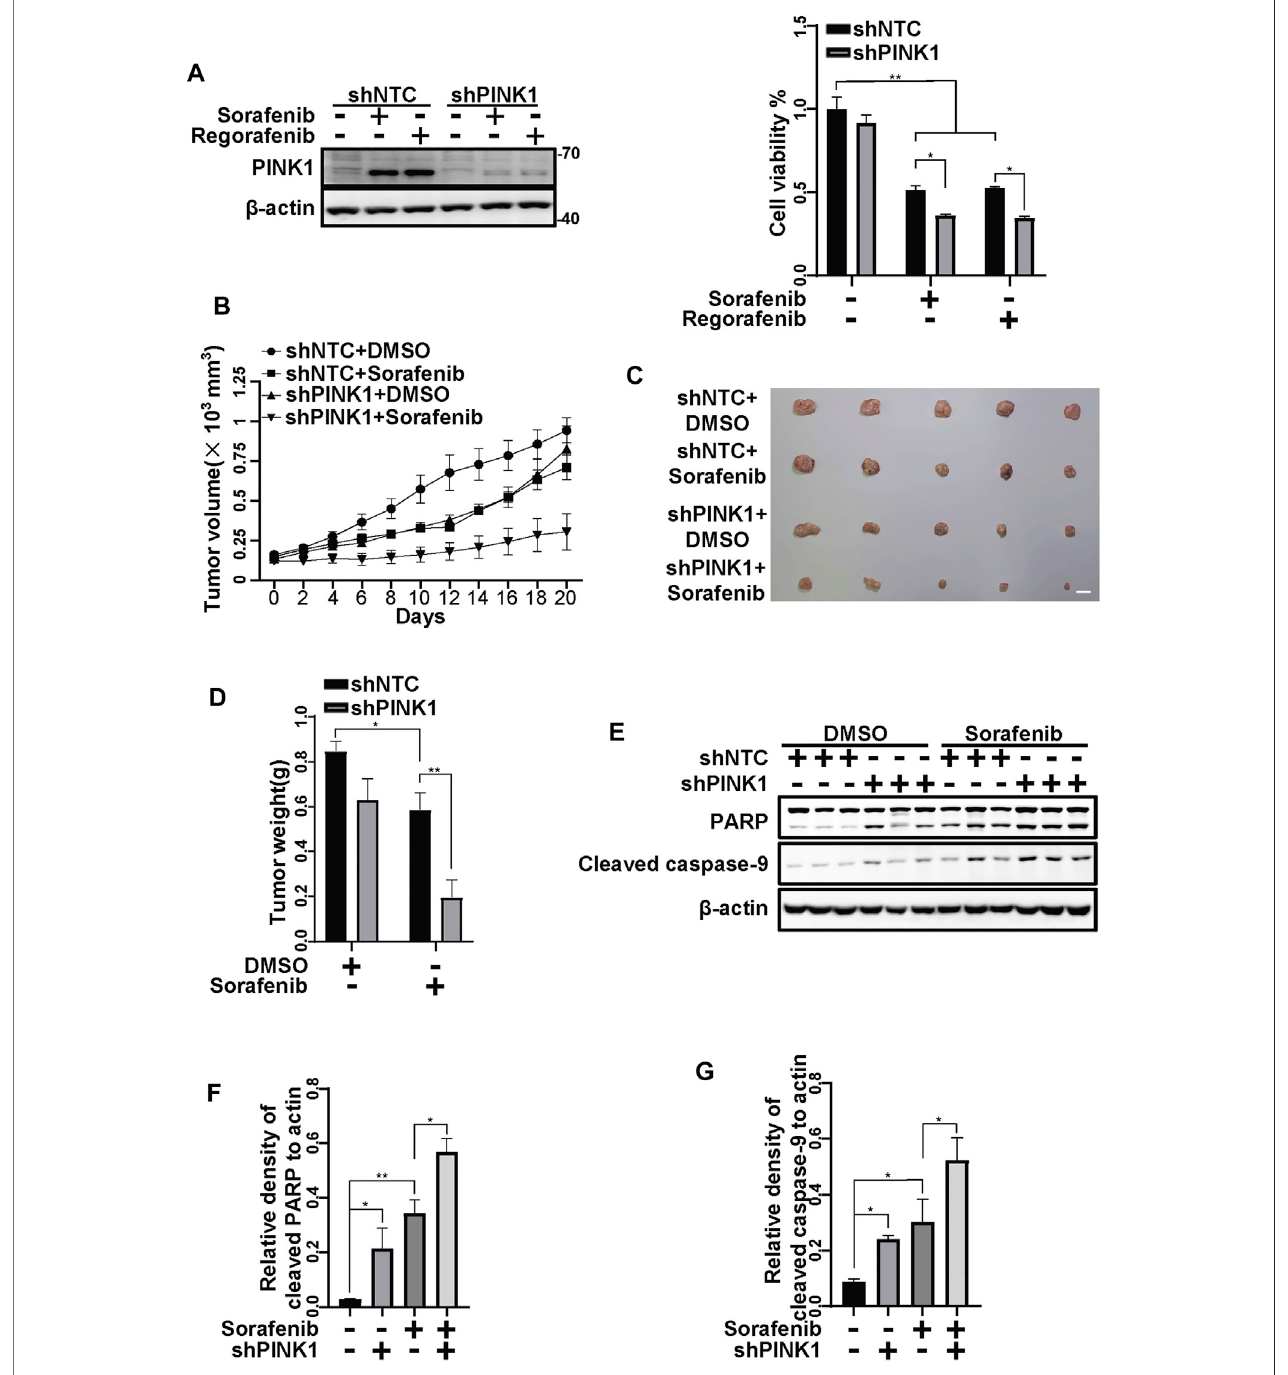
FIGURE 8 | Targeting PINK1 effectively promotes sorafenib repressive effects on tumor growth in vivo . (A) HepG2 cells that stably expressed shNTC or shPINK1 were treated with sorafenib (20 μ M) or regorafenib (30 μ M) for 24 h and subjected to western blotting with the indicated antibodies. Cell viability was measured using CCK-8 kit. Values are the mean ± SEM from four independent experiments (* p < 0.05, ** p < 0.01, two-way ANOVA and Tukey ’ s multiple comparisons test). (B) Growth curves of tumors that stably expressed shNTCs or shPINK1 in animals treated with or without sorafenib are shown. (C,D) Representative xenograft tumors at the endpoint are shown. The graph shows the weight of tumors in each group ( n = 5, scale bar, 1 cm * p < 0.05, ** p < 0.01, two-way ANOVA and Tukey ’ s multiple comparisons test). (E) Thecleavages ofPARPandcaspase-9 intumor tissues from (B) weredetected using immunoblot analysis. (F,G) Therelative densities ofcleaved PARP (F) and cleaved caspase-9 (G) were quanti fi ed, and the protein levels were normalized to the loading control ( β -actin). Values are the mean ± SEM from three independent experiments (* p < 0.05, ** p < 0.01, two-way ANOVA and Tukey ’ s multiple comparisons test).